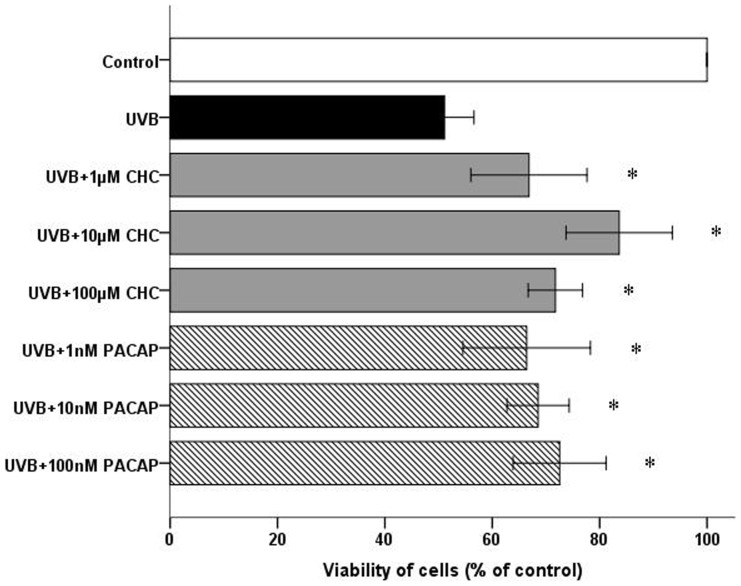
Viability of RGC-5 cells in different treatment groups at 24 h post UVB irradiation as measured by MTT assay.Co-administration of 10 µM CHC conferred the most significant protective effect compared with cells exposed to UVB only. The experiment was carried out three times independently and six replicate wells were set each time. *P<0.05, compared to UVB values.